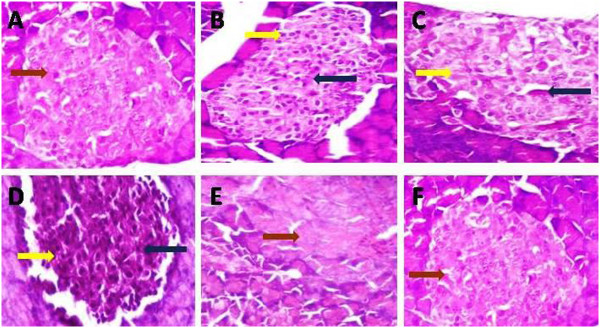
Paederia Foetida Linn. leaves extract effect on pancreas histopathology in normal and STZ induced diabetic rats. (A) Normal control: Normal control group display the normal islet (Red arrow) (B) Diabetic control: Diabetic control rat histopathology display the islet enlargement (Blue arrow) and focal necrosis (Yellow arrow) (C)PF I (100 mg/kg): PF tested drug histopathology display bigger size of islet (Blue arrow) and focal necrosis (Yellow arrow) (D)PF II (250 mg/kg): Other PF tested drug display focal necrosis (Yellow arrow) and islet enlargement (Blue arrow). (E)PF III (500 mg/kg): PF tested drug display normal size of islet (Red arrow) (F) Glibenclamide (10 mg/kg): Glibenclamide treated group rat histopathology display normal islet (Red arrow) similar to the normal control group. For each group 6 rats were examined and 50 pictures were taken. Original magnification, 40×.